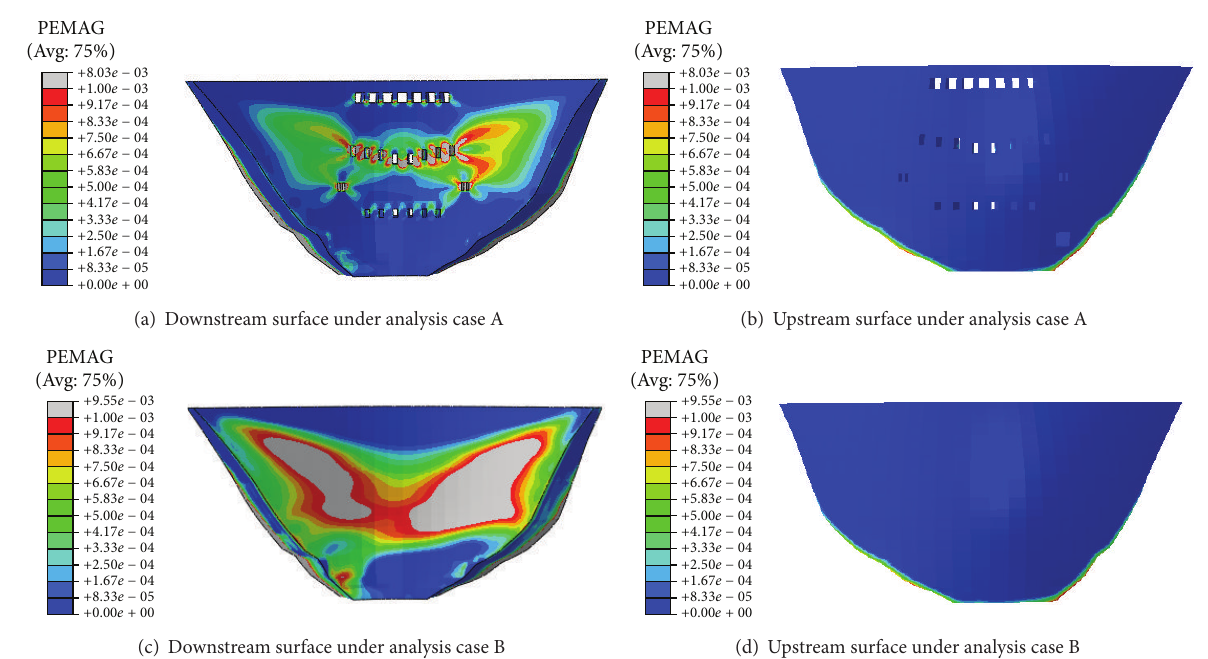
Figure 12: Yield zone in dam under various analysis cases (6 times